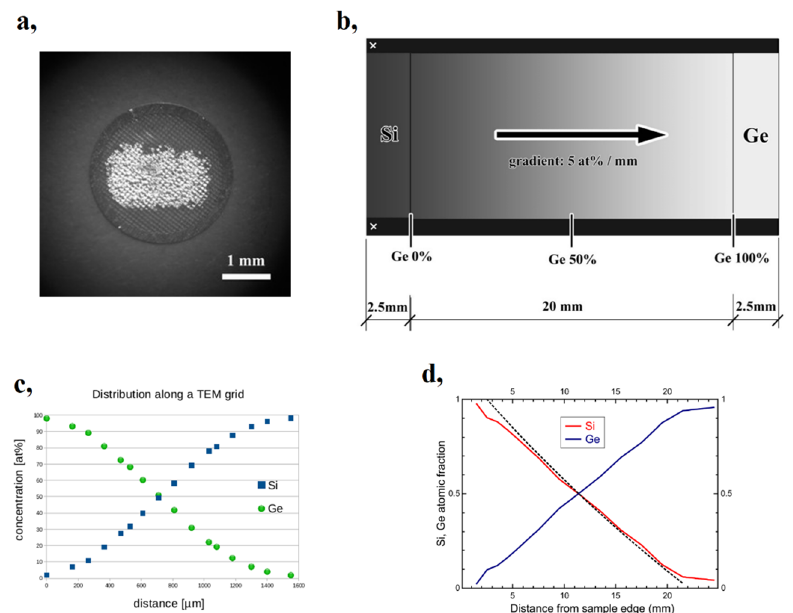
Figure 11. Si x Ge 1 ‐ x (0 ≤ x ≤ 1) thin films fabricated via the micro ‐ combinatorial method ( a ) on a Mo grid for TEM measurements. ( b ) A schematic of the sample for spectroscopic ellipsometry investi ‐ gations. ( c ) The compositional change across the TEM grid obtained by TEM EDS and ( d ) along the 10 × 25 mm 2 Si slab obtained via RBS (continuous line) and EDS (dashed line); ( d ) was reproduced with permission from [59]. Copyright © 2018, MDPI, Basel, Switzerland.